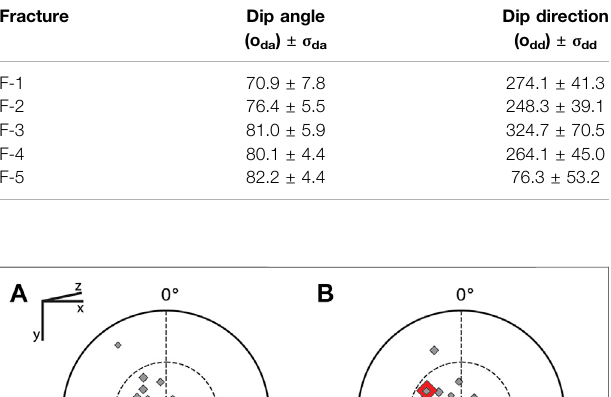
TABLE 3 | Mean apertures and standard deviations (both in px and mm) for the analyzed intersections. Intersection